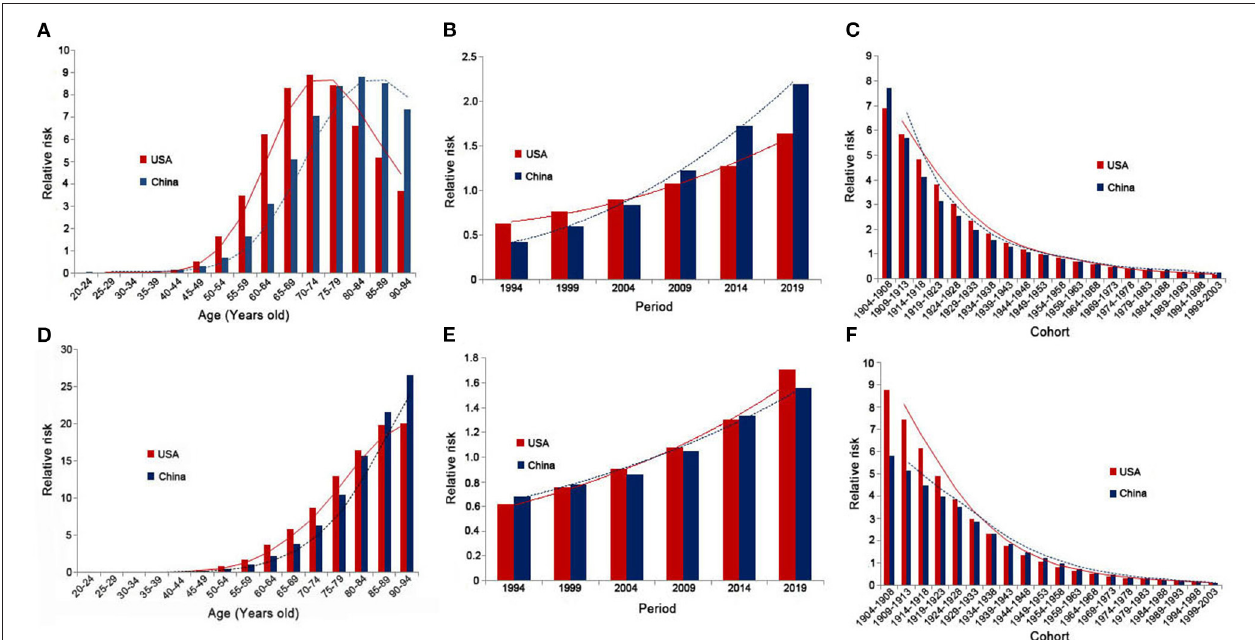
FIGURE 4 | Relative risks of prostate cancer incidence and mortality rates in China and the USA from 1990 to 2019 due to age [ (A) incidence rate; (D) mortality rate], period [ (B) incidence rate; (E) mortality rate], and cohort [ (C) incidence rate; (F) mortality rate]